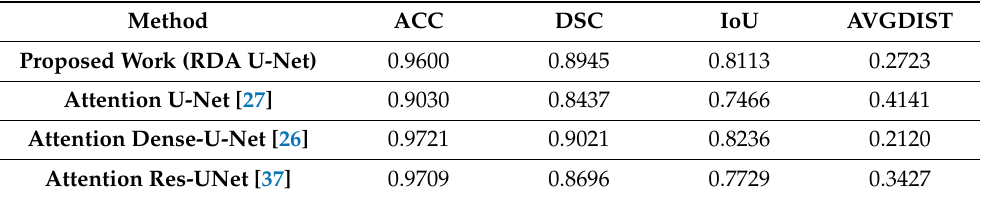
Table 2. Results of different models for evaluation of liver